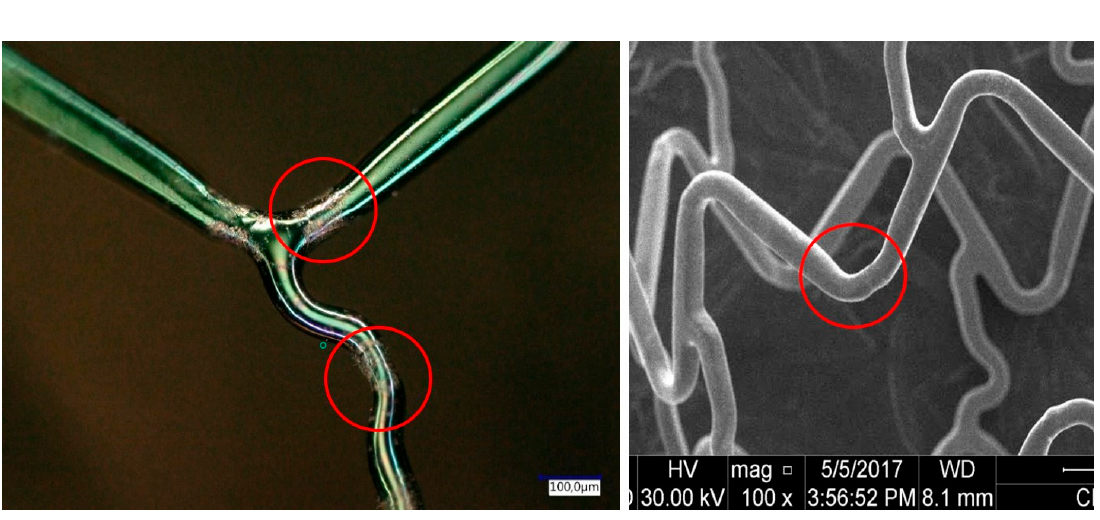
Figure 4. Crown design: ( a ) low and ( b ) high radius of curvature in the middle area of the crown. Coating integrity plays a major role for reliability and safety of the stent device. Effects, such as cracking, delamination, and peeling off a stent surface are associated with serious health risks